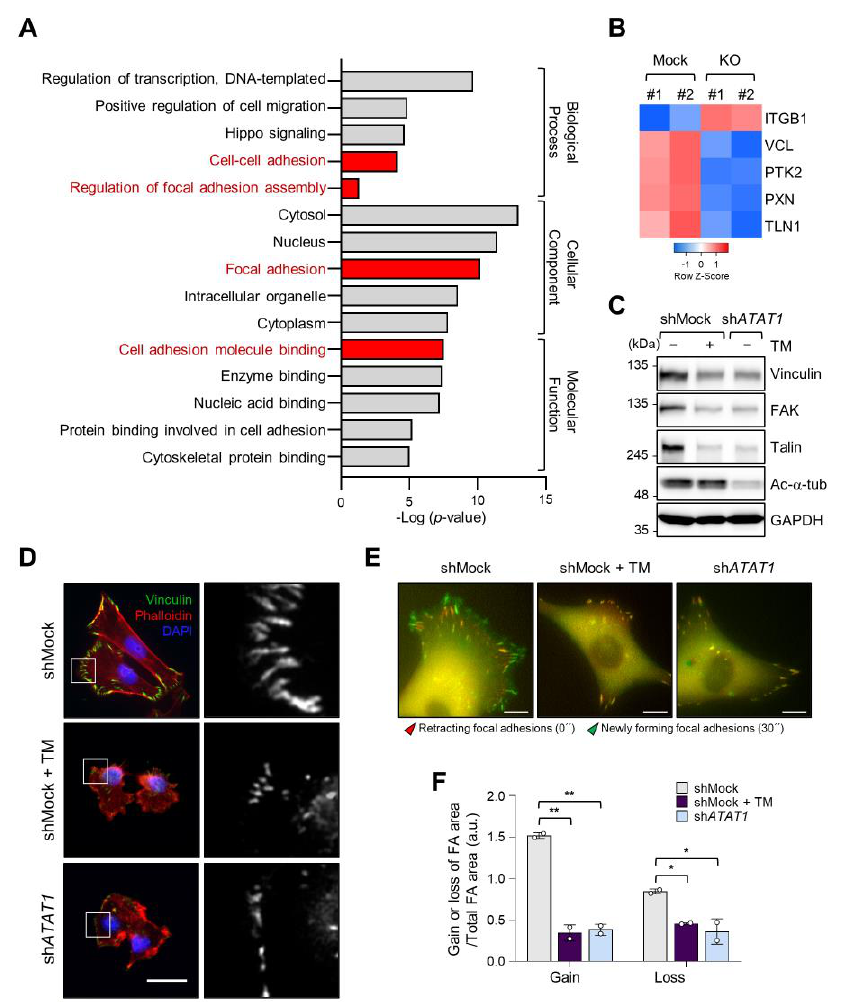
Figure 4. Focal adhesion assembly is regulated by microtubule acetylation and ER stress. ( A ) Func- tional annotation of 389 DEGs in ATAT1 KO MDA-MB-231 cells using PANTHER gene ontology (GO). ( B ) Heatmap showing genes related to focal adhesion assembly based on RNA-seq data from ATAT1 KO cells. ( C ) Validation of gene expression using Western blotting. shMock-treated cells treated or not with tunicamycin, and sh ATAT1 -treated cells were cultured for 24 h. Cell lysates were used for Western blot analysis of vinculin, FAK, talin, and acetylated α -tubulin, using GAPDH as a loading control. ( D ) Immunocytochemistry analysis of focal adhesions using antibodies against vinculin and F-actin in shMock-treated and ATAT1 KO cells cultured in the presence of 20 ng/mL tunicamycin for 24 h. Scale bar, 30 µ m. ( E ) Paxillin-GFP-expressing shMock- and sh ATAT1 #1-treated MDA-MB-231 cells were starved for 16 h in serum-free RPMI1640 medium and then stimulated with 10% FBS with or without 20 ng/mL tunicamycin. Merged paxillin–GFP images in shMock- and sh ATAT1 #1-treated cells at 0 and 30 min. Red represents retracting focal adhesions and green represents newly forming focal adhesions. Scale bar, 10 µ m. ( F ) Ratios of gain and loss of focal adhesions to total focal adhesion area. Values represent the mean ± SD of two independent experiments. Statistical significances were analyzed using one-way ANOVA followed by Tukey multiple comparison tests. One-way ANOVA (Loss; F 2, 3 = 15.98. * p < 0.05, Gain; F 2, 3 = 174.1, ** p <